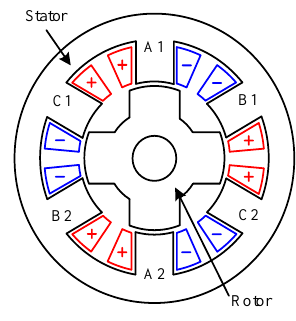
Figure 1. Topology of 6/4 VFRM.